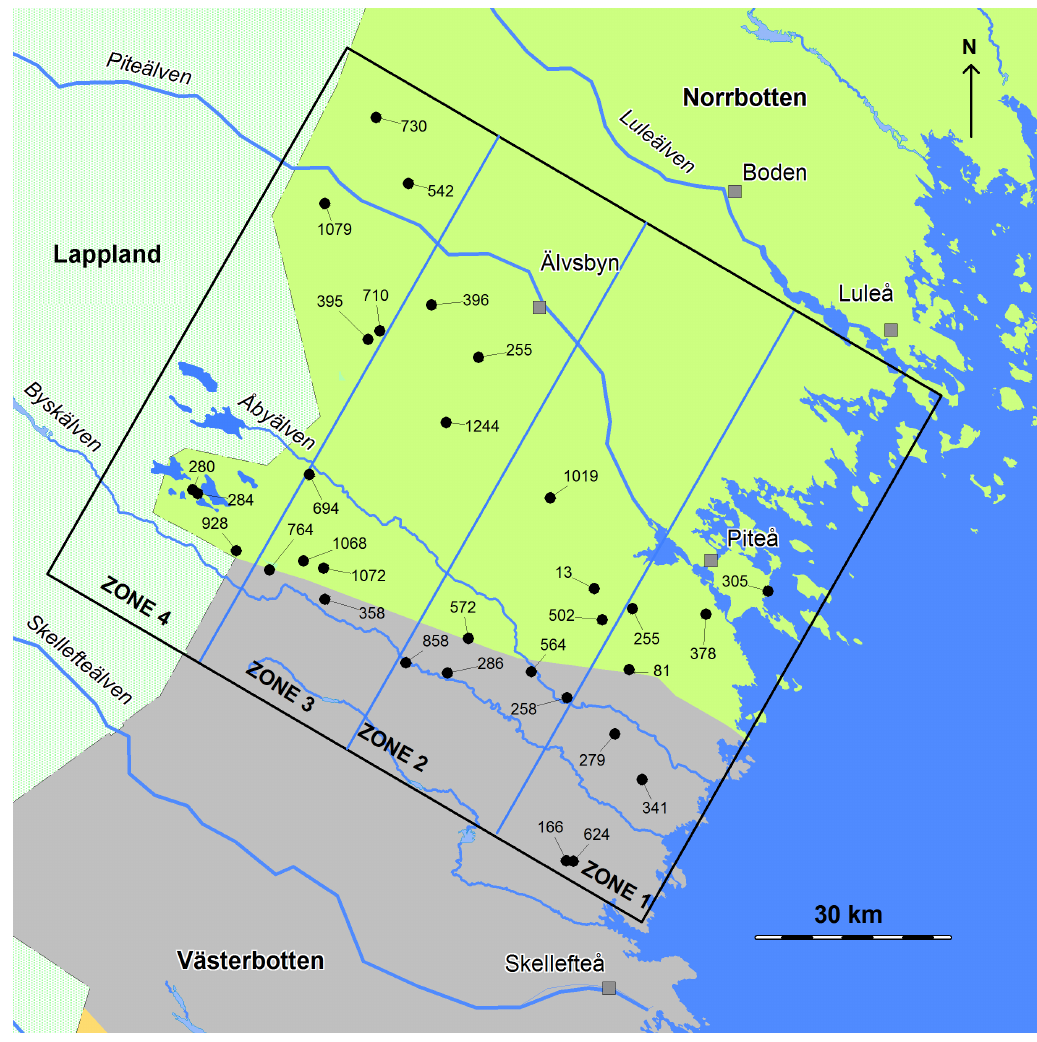
Figure 4. Excavated hearths in the study area, zones